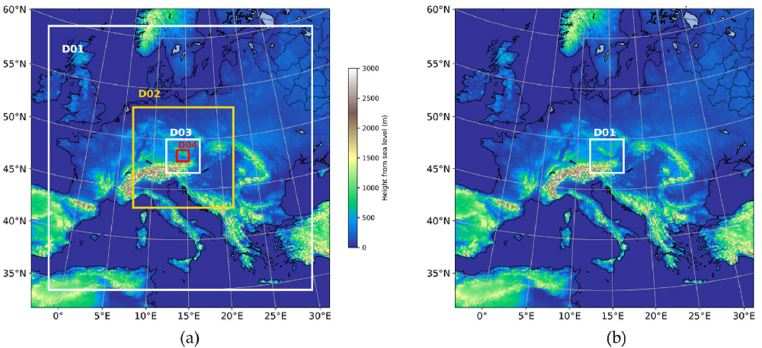
Figure 1. WRF domain setup ( a ) high resolution four nested domains (4D); ( b ) coarse single domain (1D). domain